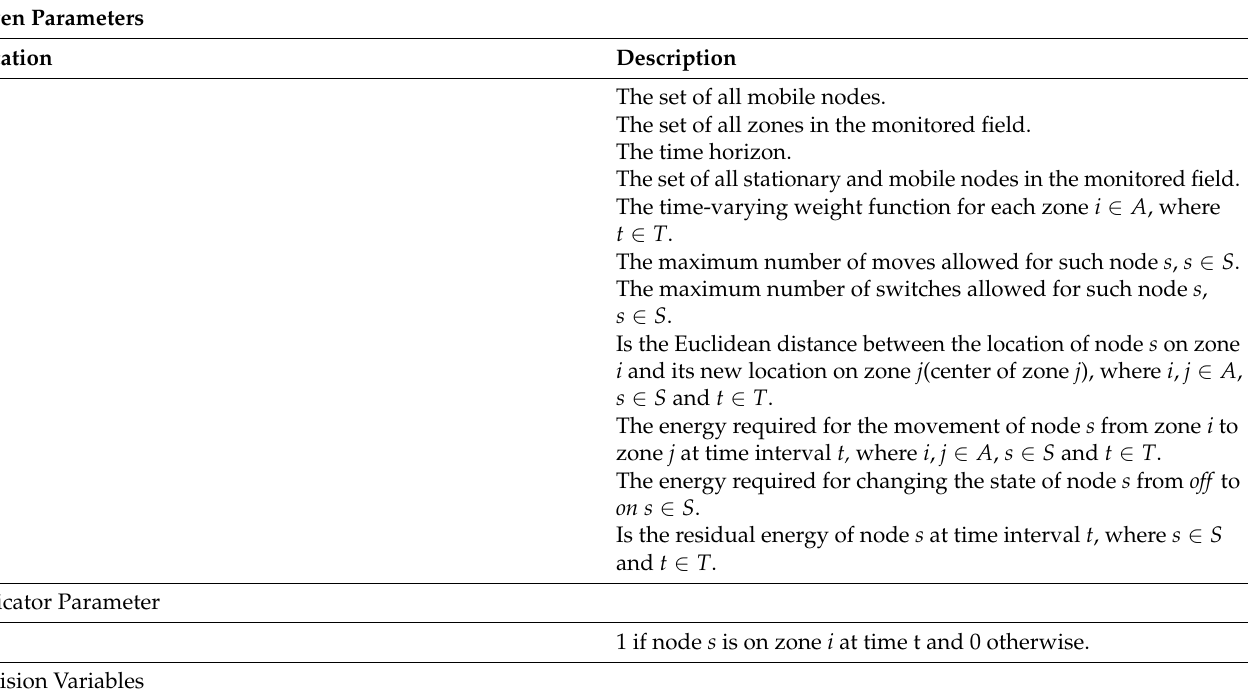
Table 2. Deployment problem model